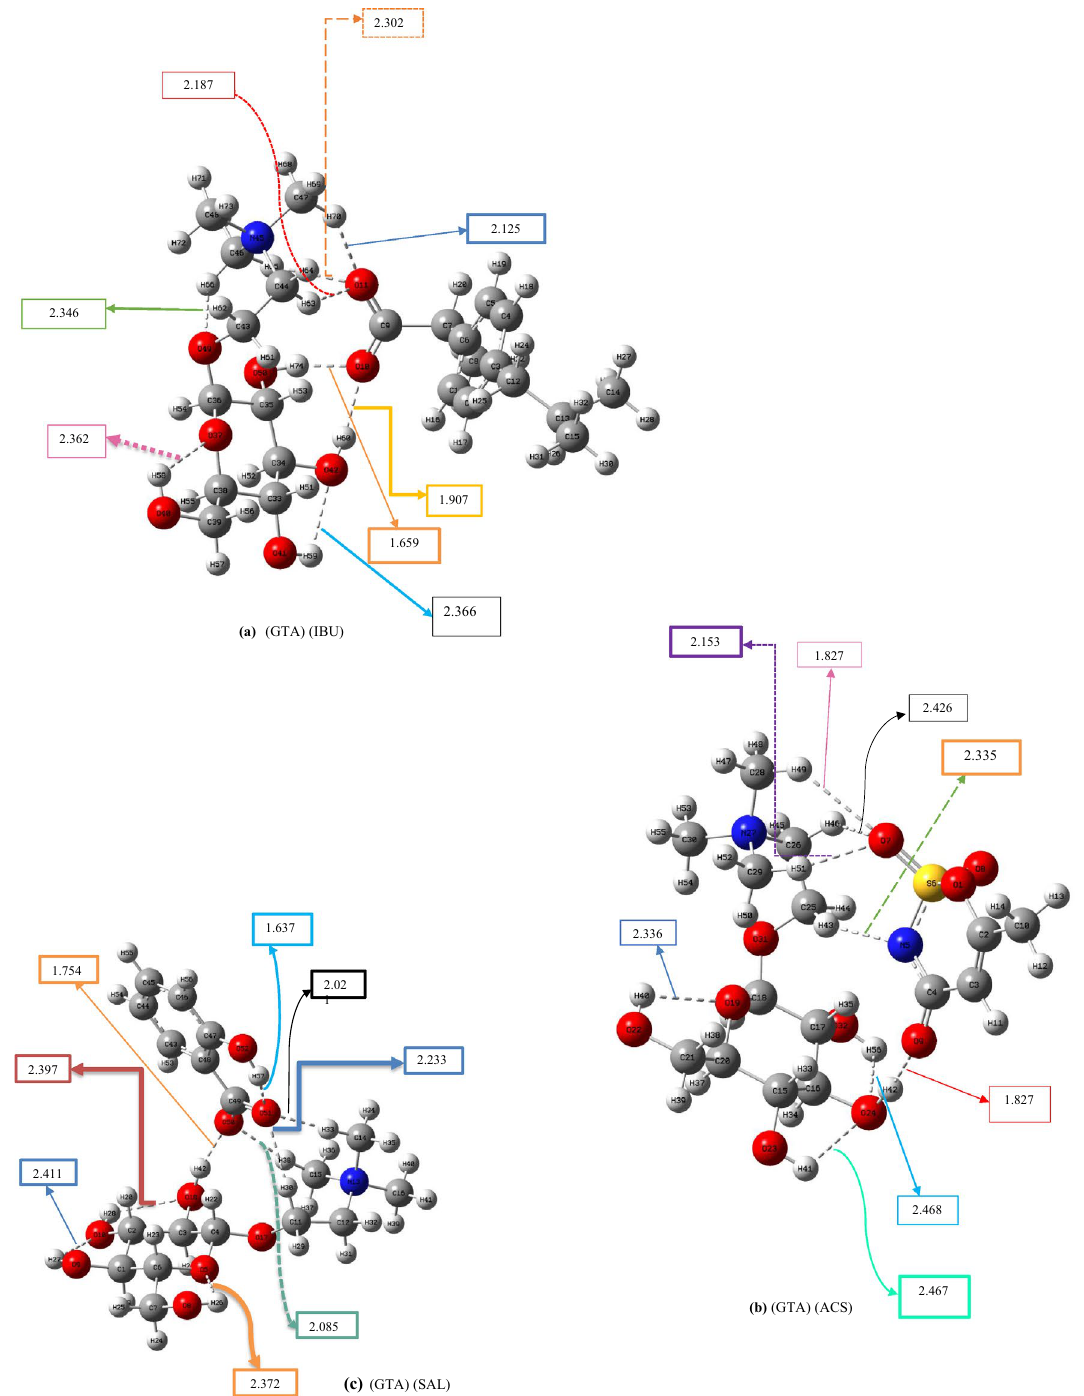
Figure 2. Optimized geometries of the lowest-energy conformers of N,N,N -trimethyl-2-(((2 R ,3 R ,4 S ,5 S ,6 R )- 3,4,5-trihydroxy-6-(hydroxymethyl)tetrahydro-2H-pyran-2-yl)oxy)ethan-1-aminium-based ILs including: (